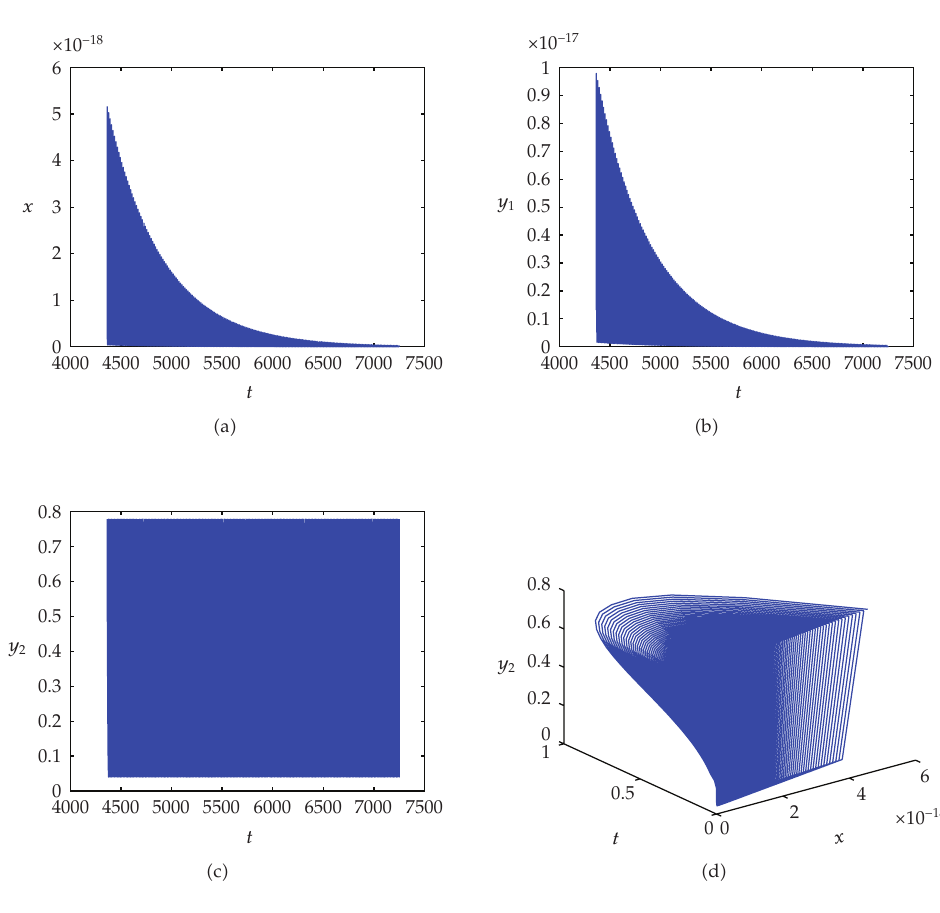
Figure 1: The dynamics of system (cid:2) 1.1 (cid:3) with r (cid:6) 1 , a (cid:6) 1 , b (cid:6) 4 , k (cid:6) 2 , m (cid:6) 0 . 8 , D (cid:6) 0 . 4 , v 1 (cid:6) v 2 (cid:6) 0 . 2 , l (cid:6) 0 . 5 , δ (cid:6) 0 . 1 , δ 1 (cid:6) 0 . 5 , δ 2 (cid:6) 0 . 1 , q (cid:6) 0 . 74 , T (cid:6) 14 . 5 and initial values x (cid:6) 8 . 5 , y 1 (cid:6) 4 . 8 , y 2 (cid:6) 2 . 8. (cid:2) a (cid:3) Time series of prey; (cid:2) b (cid:3) time series of immature predator; (cid:2) c (cid:3) time series of mature predator; (cid:2) d (cid:3) phase portrait of system (cid:2) 1.1 (cid:3)